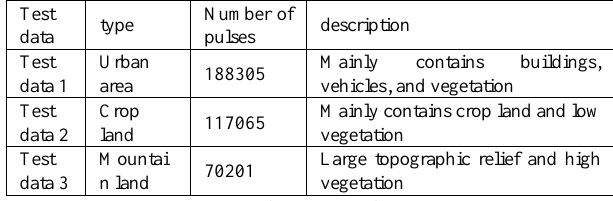
Table 1. Information of test data land and mountain land respectively, in which, (a) is the original point cloud, (b) is the filtered point cloud. Furthermore, we filtered these data sets by traditional method, adaptive TIN method and our method, and I class error rate, II class error rate and total error rate are counted separately. I class error rate is the rate that ground points are classified as non-ground points; II class error rate is the rate that non-ground points are classified as ground points; total error rate is the weighted sum of I and II class error rate. The adaptation is represented by I and II class error rate, and the feasibility is reflected by total error rate (Huang Xianfeng, 2009). Reference filtering results are edited by